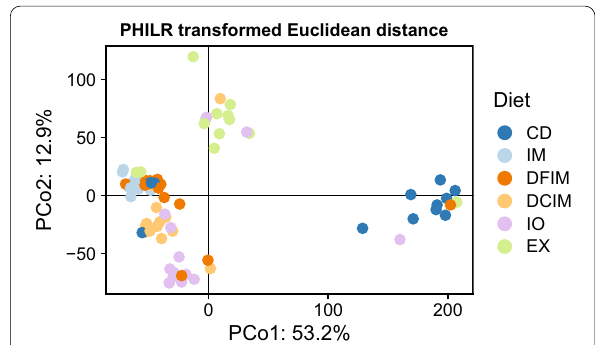
Fig. 7 The beta-diversity (based on phylogenetic isometric log-ratio (PHILR) transformed Euclidean distance matrix) of gut microbiota in fish fed experimental diets. PCo principal coordinate; CD control diet; IM full-fat BSF (black soldier fly) larvae meal diet; DFIM defatted BSF larvae meal diet; DCIM de-chitinized BSF larvae meal diet; IO BSF larvae oil diet; EX BSF larvae exoskeleton